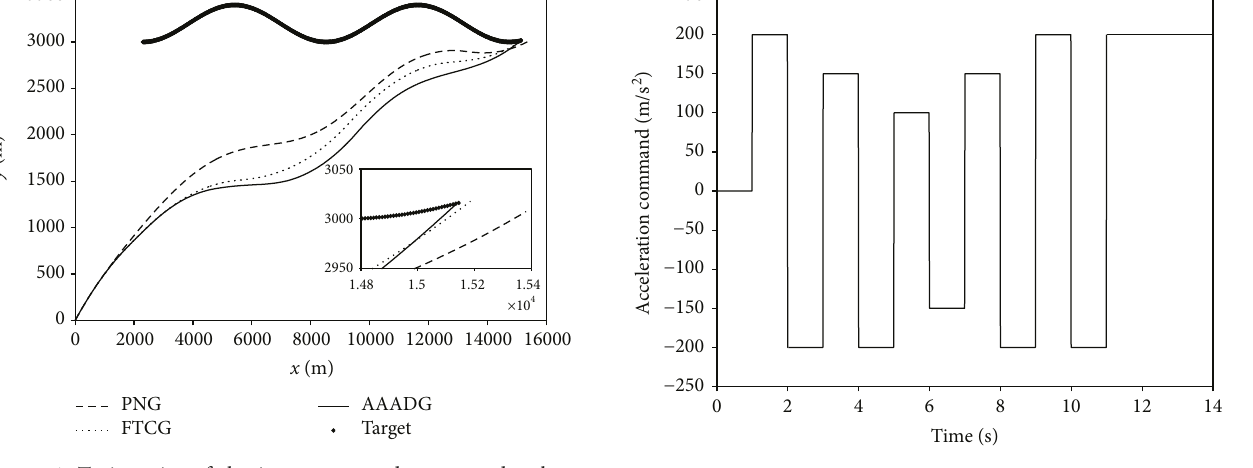
Figure 6: Target